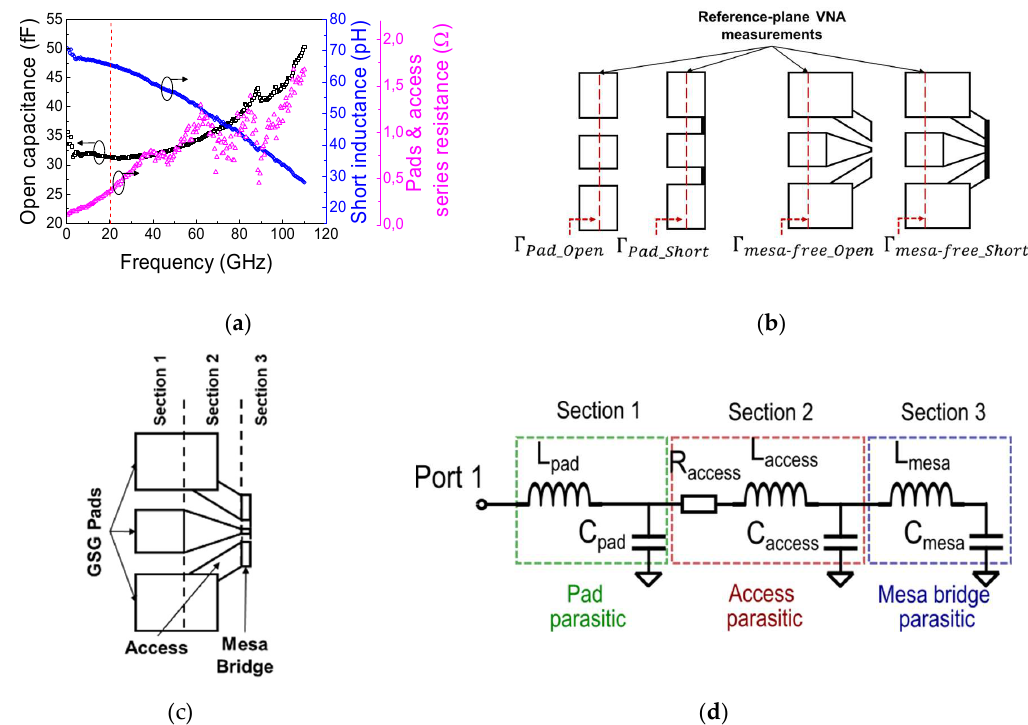
Figure 5. ( a ) Extraction of capacitive, inductive, and resistive parasitic equivalents to the pads and access lines; ( b ) schematic of the complimentary test structures; ( c ) schematic of the UTC-PD depicting the three parasitic sections; ( d ) global electrical circuit equivalent to the pads and access lines.